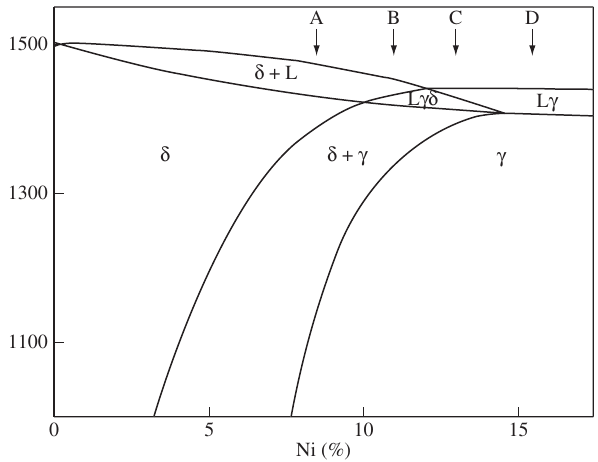
Figure 1. Temperature (°C) vs. nickel content (in wt. (%)). Section through Fe- Ni-Cr phase diagram at 19 wt. (%) Cr showing four solidification modes 3 .